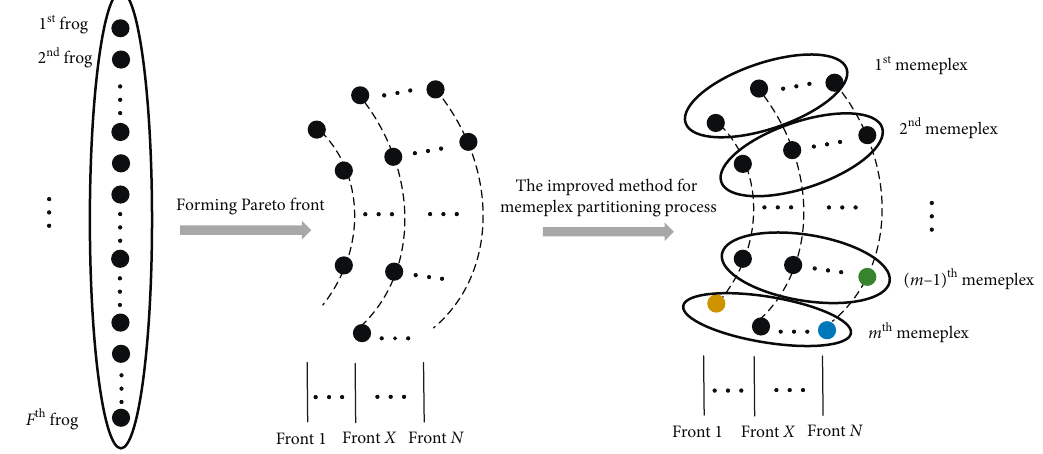
Figure 3: The improved method for memeplex partitioning